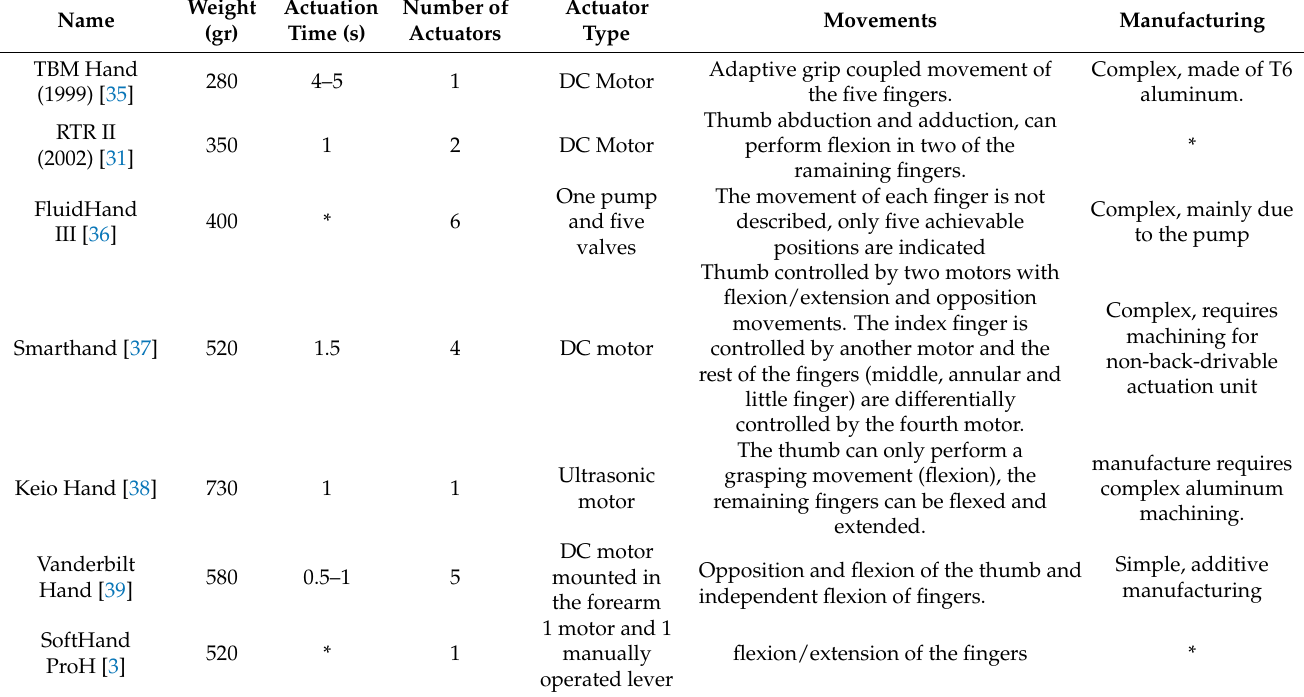
Table 1. Summary of research hand prostheses and their main